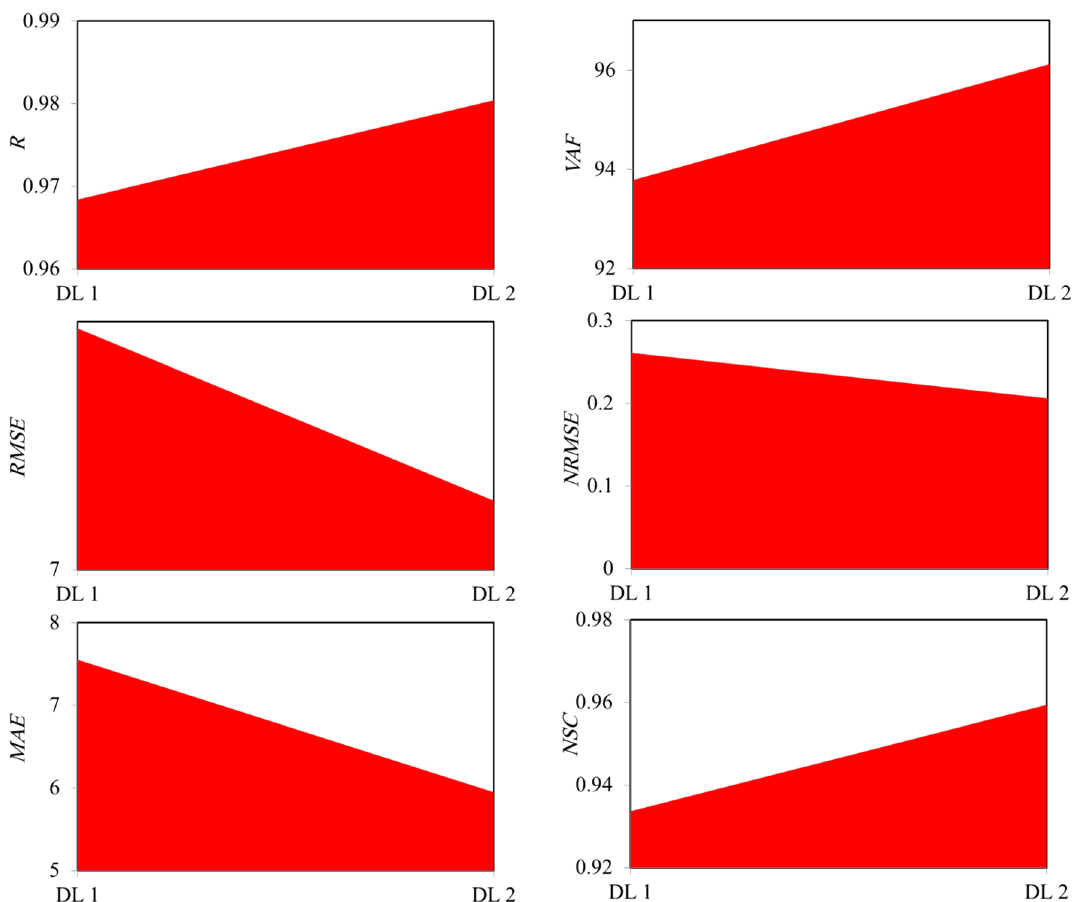
Fig. 7 Results of different statistical indices calculated to estimate precipitation values by DL 1 and DL